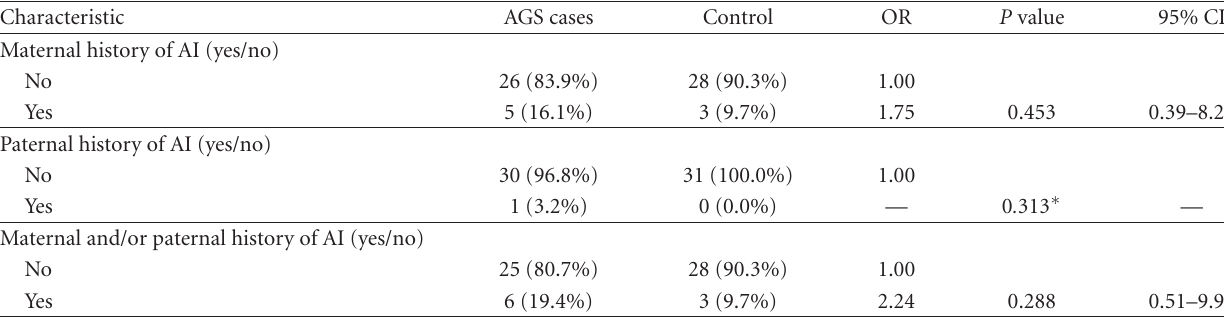
Table 1: History of autoimmune disease in parents of cases and controls.